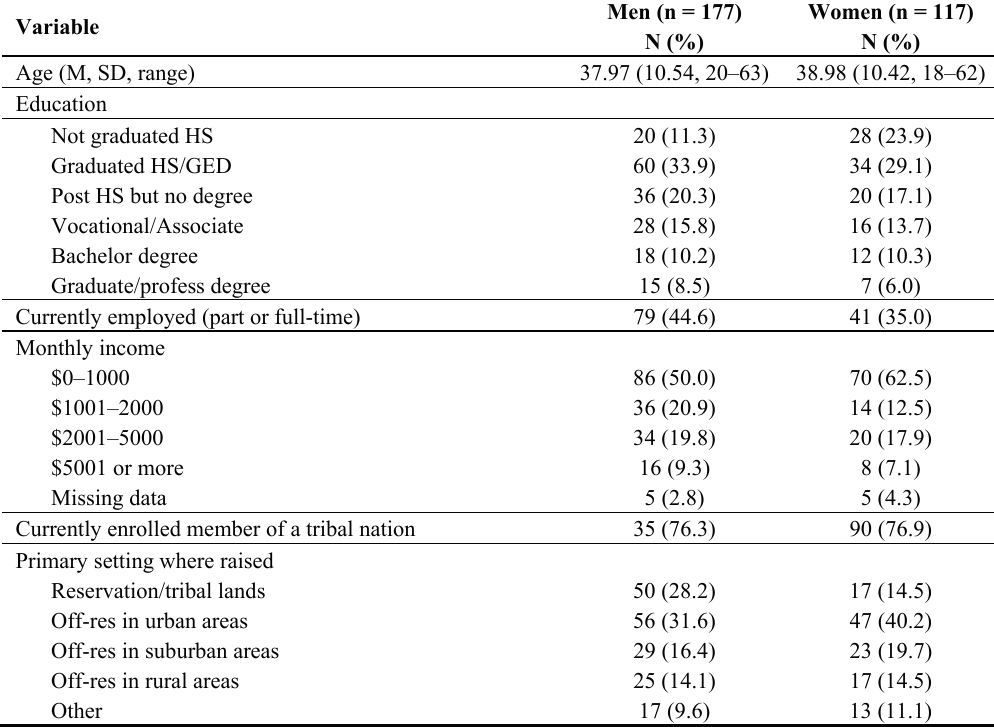
Table 1. Demographic characteristics of study participants (N =